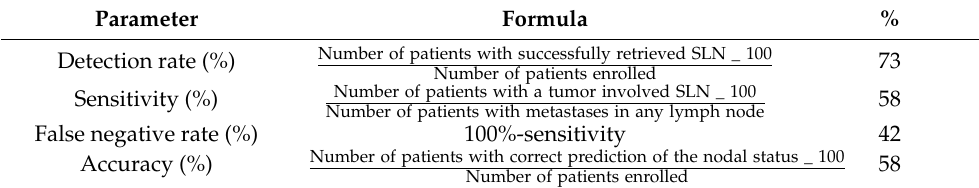
Table 3. Sentinel mapping efficacy